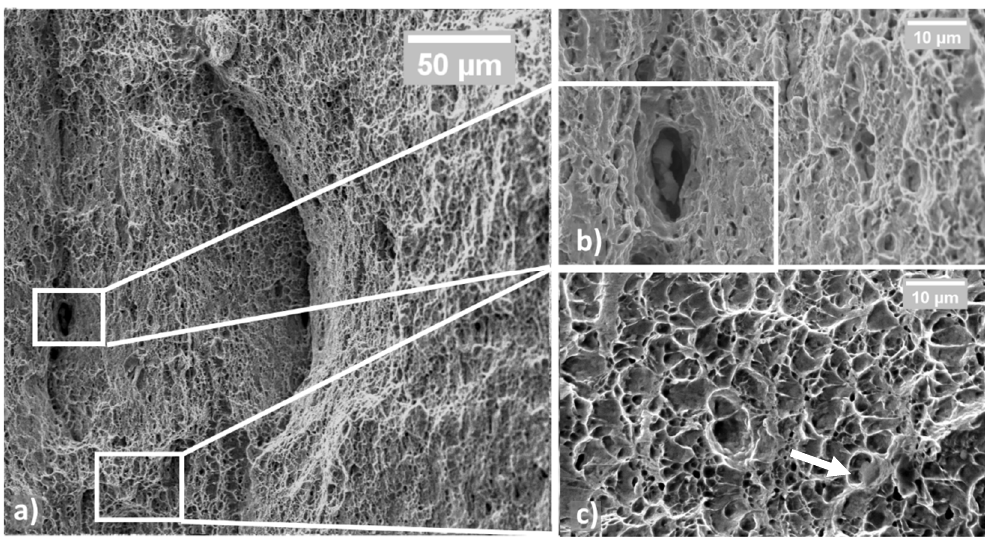
Figure 6. Fractured surface in cold-rolled BF steel samples; the appearance at low magnification is mainly ductile ( a ); some secondary phase was found, i.e., carbides ( b ); at high magnification, dimples are visible ( c ).